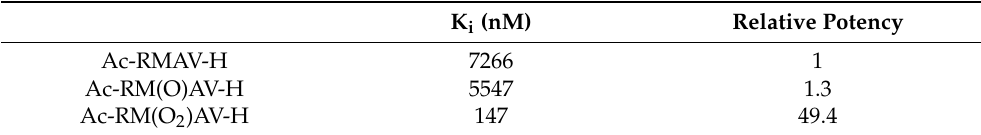
Table 2. Comparison of the HNE peptide aldehyde inhibitor Ac-RMAV-H with derivatives containing P3 methionine residues in sulfoxide and sulfone